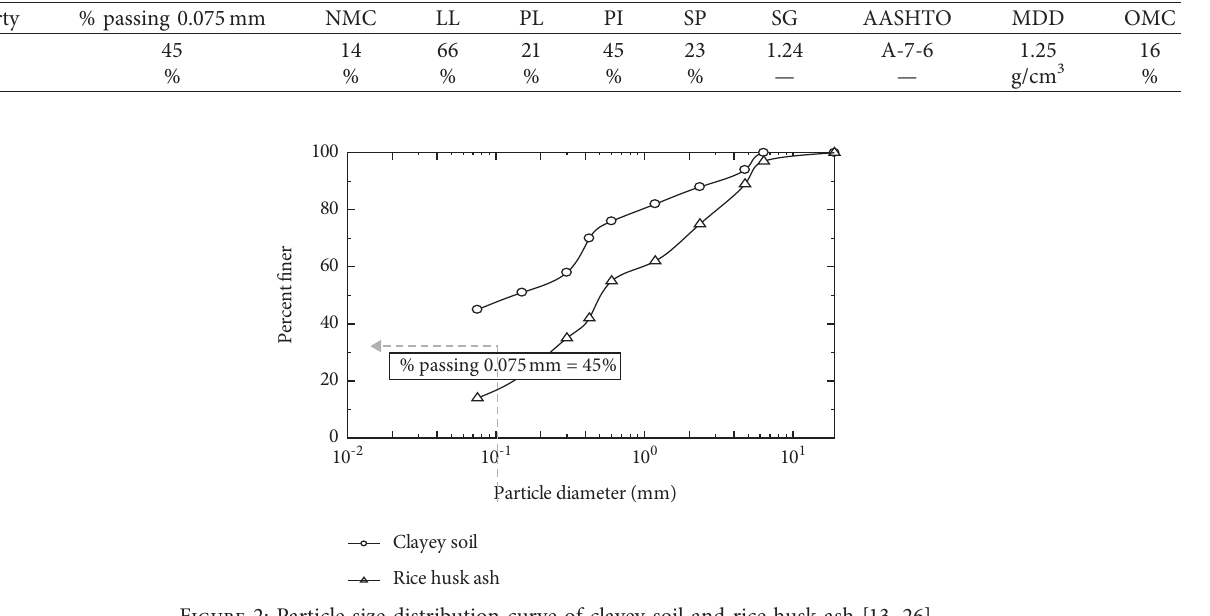
Table 4: Preliminary properties of the reference soil at 60% saturation.